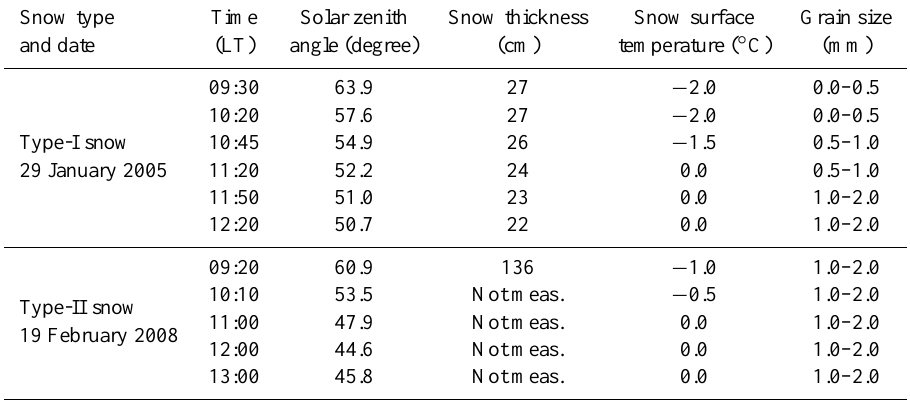
Table 1. Field measured snow parameters at the time of reflectance observations (Not meas. is no measurement recorded). Snow